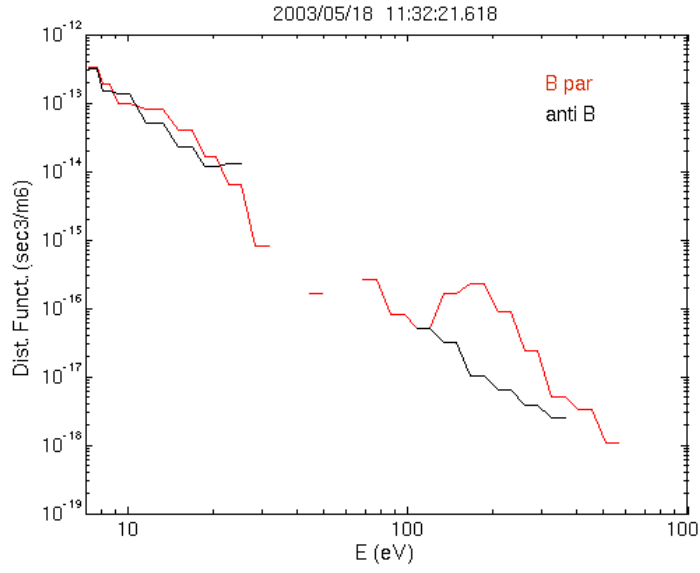
Fig. 13. 18 May 2003. Electron distribution function at 11:32:21.618 UT for upgoing electrons (black) and downgoing electrons (red) computed from PEACE